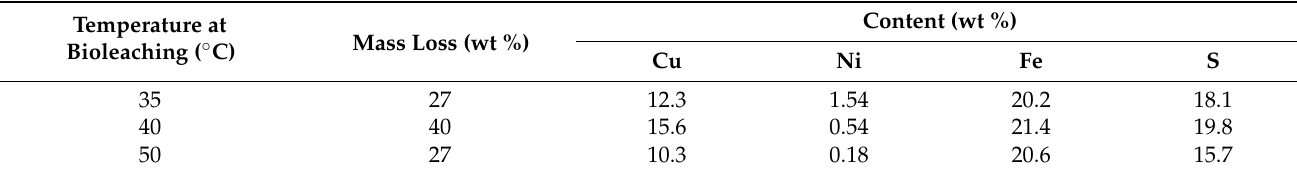
Figure 5. Optical micrographs of ( a ) the original concentrate and solids after their bioleaching at ( b ) 35, ( c ) 40, and ( d ) 50 ◦ C, respectively (Pn, pentlandite; Vo, violarite; Cp, chalcopyrite; Py, pyrite; Po, pyrrhotite). Table 4. Mass loss of concentrate during bioleaching and content of main elements in bioleach residues (pulp density, 1 wt %; duration, 22